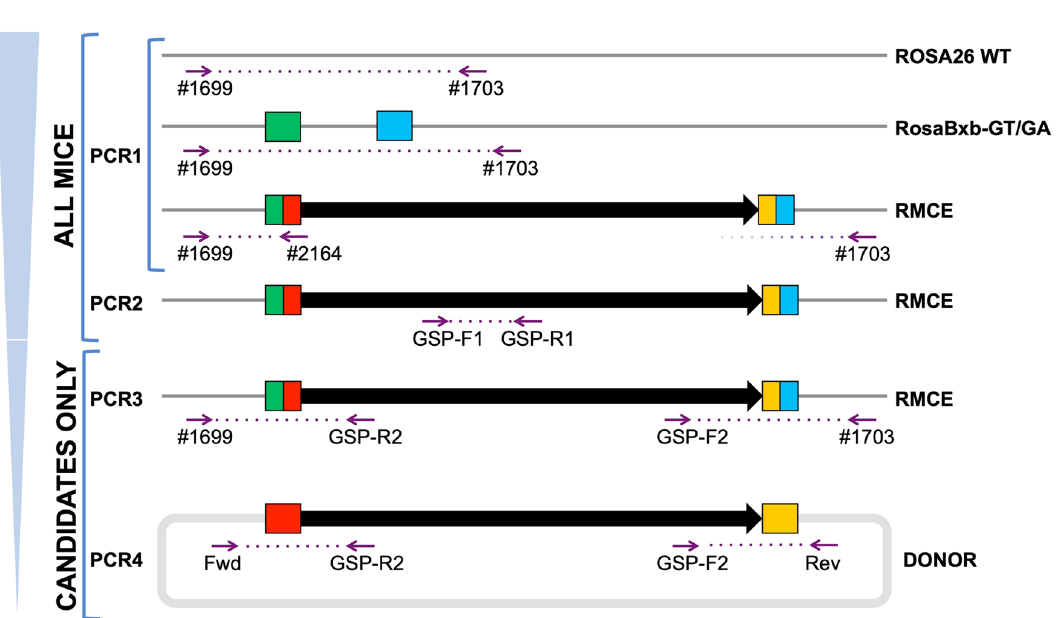
Figure 4. RMCE screening strategy. Screening offspring generated by microinjection follows a reductive series of PCRs to identify candidate animals. Both PCR1 and PCR2 assays are used to screen all potential Founder animals, while PCR3 and PCR4 assays are performed on only those positive by PCR1 and/or PCR2. A “generic” multiplex PCR1 was used to identify the presence of the RMCE allele resulting from any DNA donor, targeting both the ROSA26 locus and the recombined attR-GT site (green/red box). PCR1 serves as a DNA template quality control and used later to determine zygosity when verified animals are inbred. A project-specific